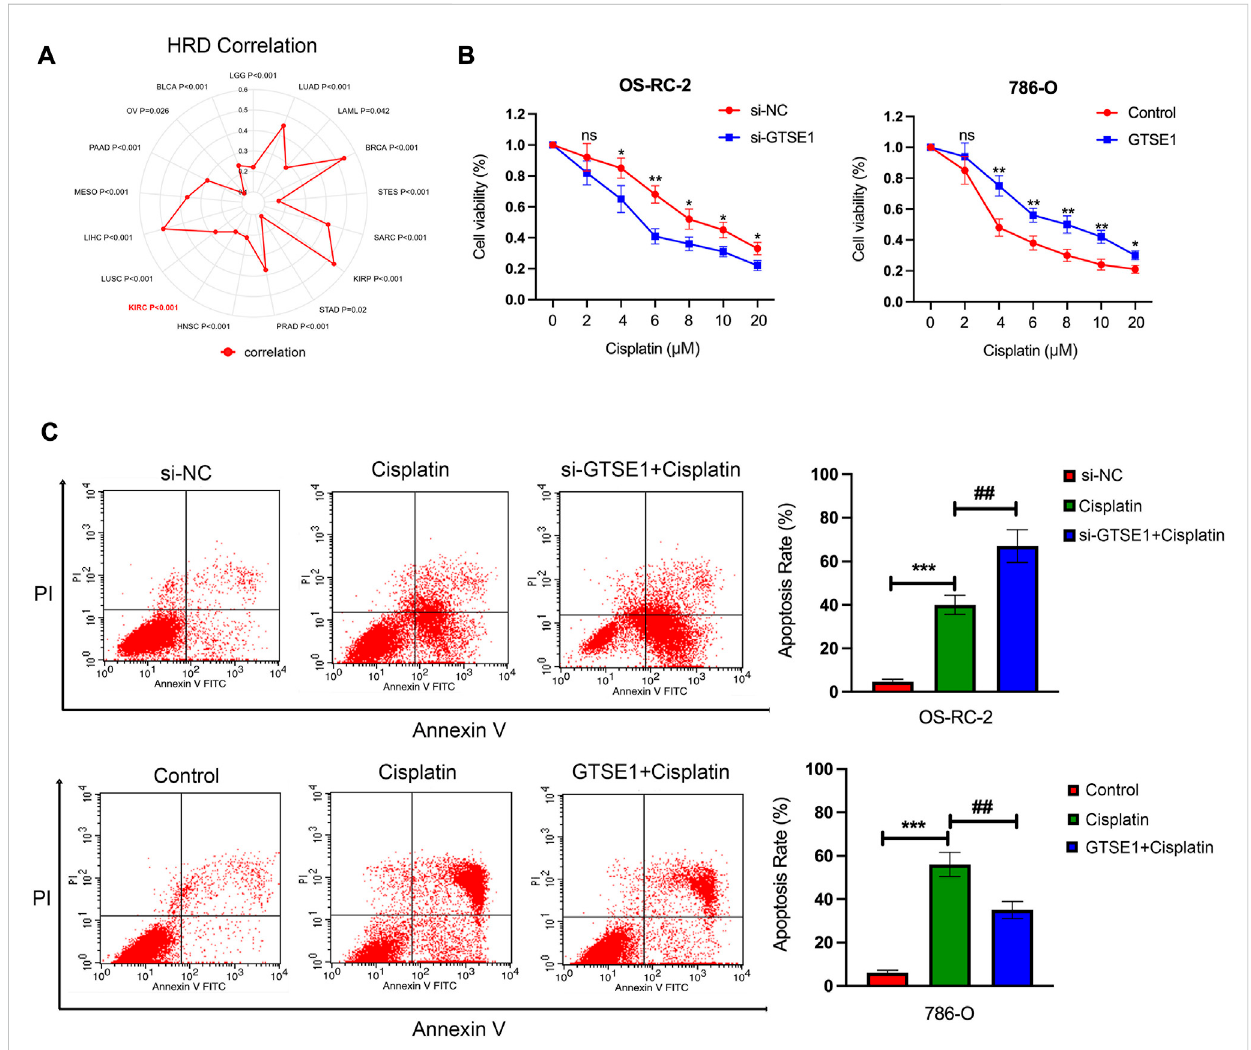
FIGURE 11 Effect of GTSE1 on cisplatin sensitivity in ccRCC cells. (A) The correlation between GTSE1 expression and homologous recombination de fi ciency (HRD) is shown in the radar map. (B) The chemosensitivity of ccRCC cells (OS-RC-2, 786-O) to cisplatin was measured using the MTT assay. (C) The